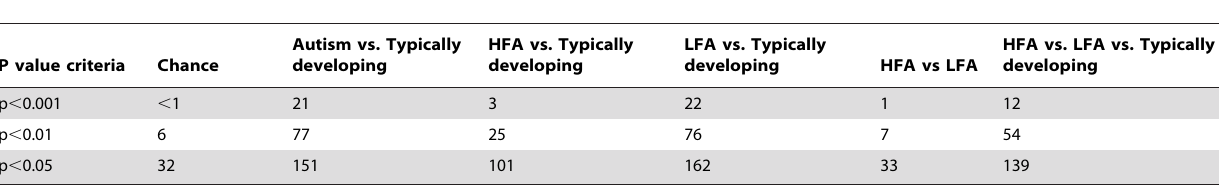
Table 2. Significantly different immunophenotyping measures (including both cell counts and fluorescence intensities) between study